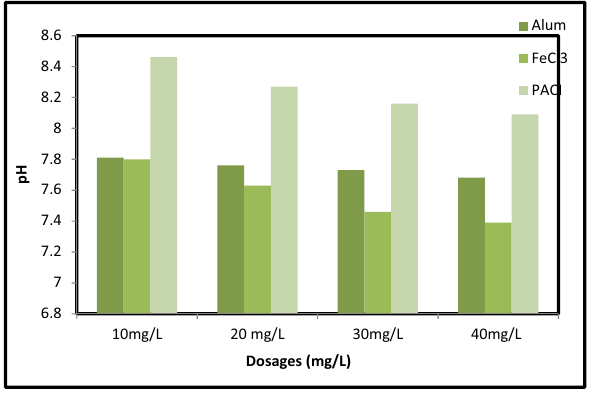
Figure 4: The relation between pH and dosage of coagulants for samples taken at 120 cm height.